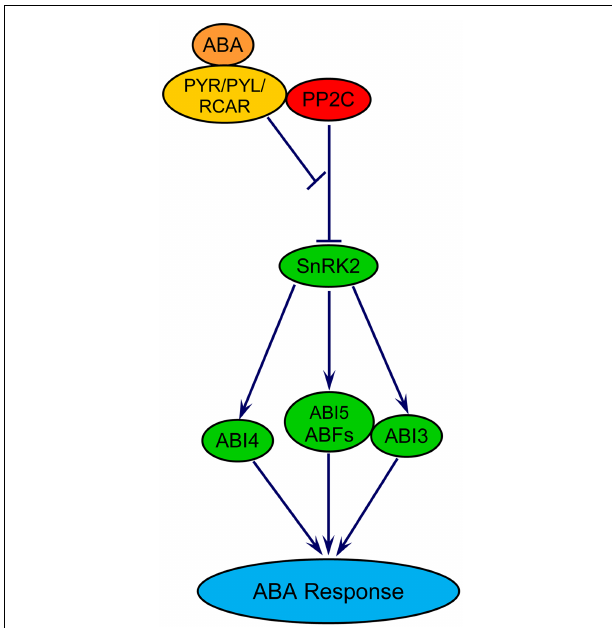
FIGURE 2 | Model forABA signaling in plants. PYR/PYL/RCAR, pyrabactin resistance/PYR-like/regulatory components of ABA receptors; PP2C, protein phosphatase 2C; SnRK, SNF1-related protein kinase2; ABF, ABA responsive element binding factor; ABI3/4/5, ABA insensitive 3/4/5. ABI3 and ABI5 proteins physically interact with each